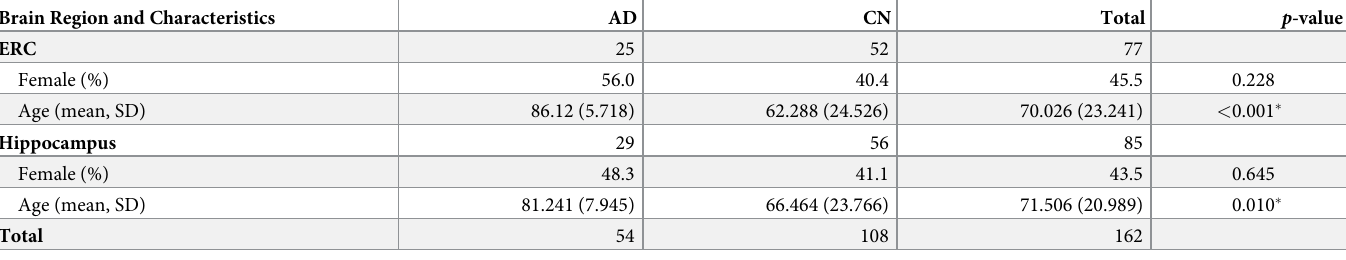
Table 2. Demographics of individuals from GEO